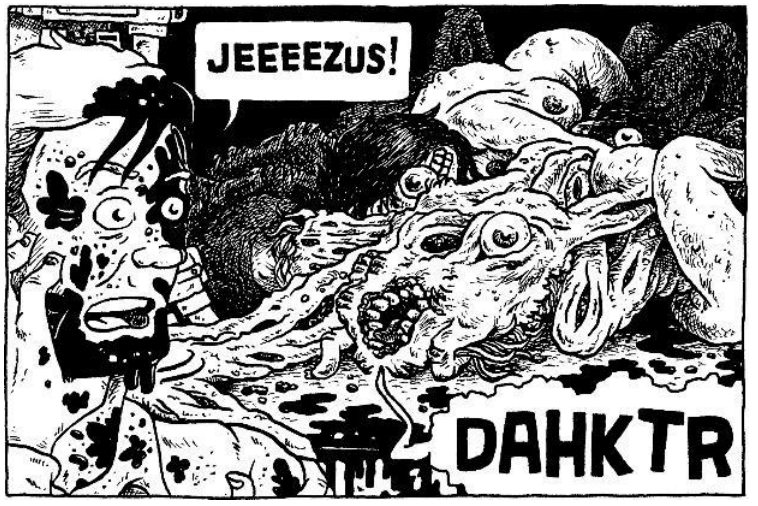
Figure 9. From Cotter, Nod Away , 147. Copyright, 2016, Joshua W